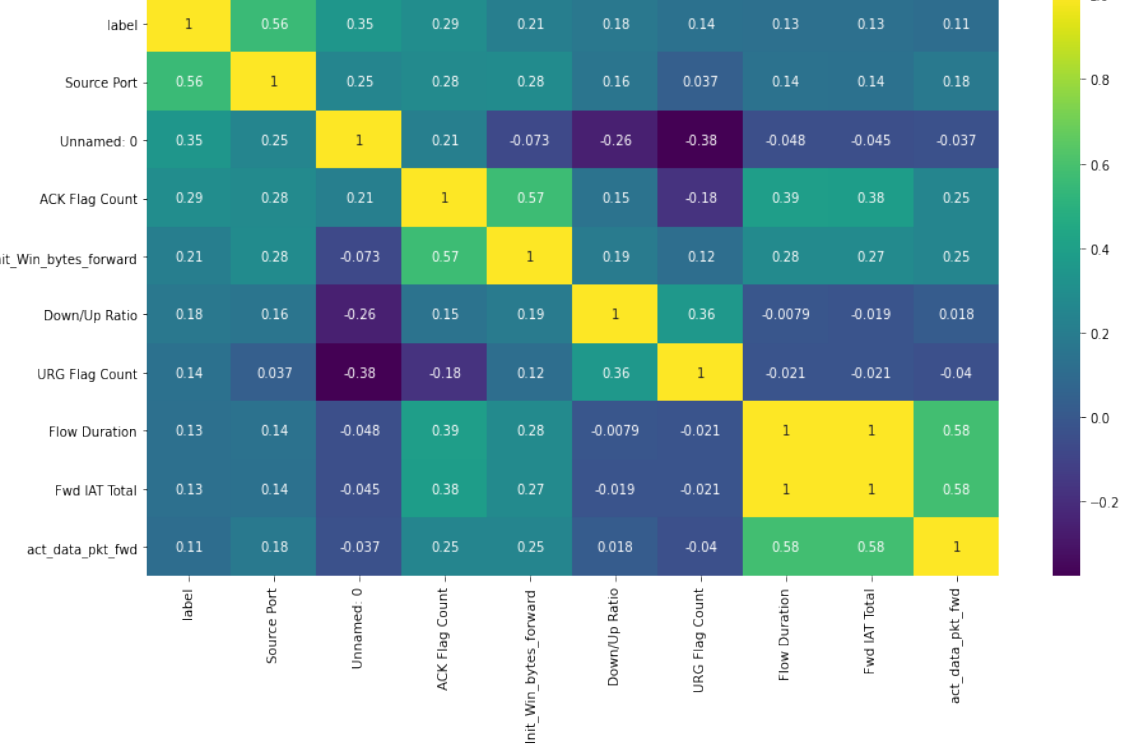
Figure 4. Selecting features by using the correlation coefficient method.